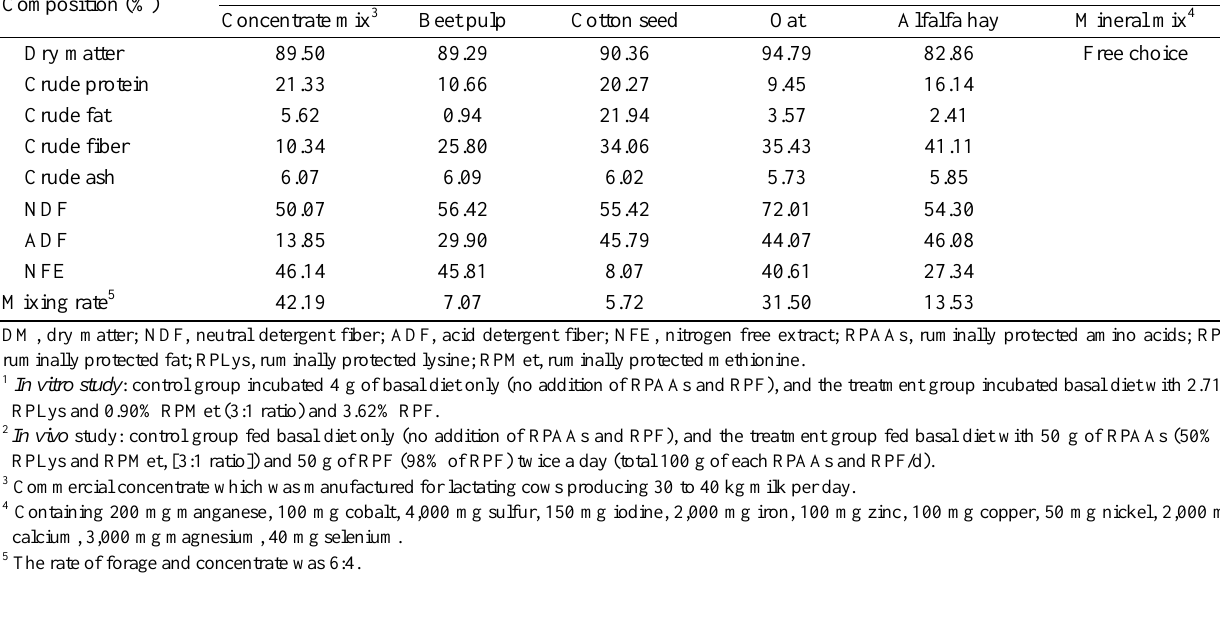
Table 1. Ingredient and chemical composition of experimental diets fed for lactating cows ( in vitro , in vivo %, DM basis) Composition